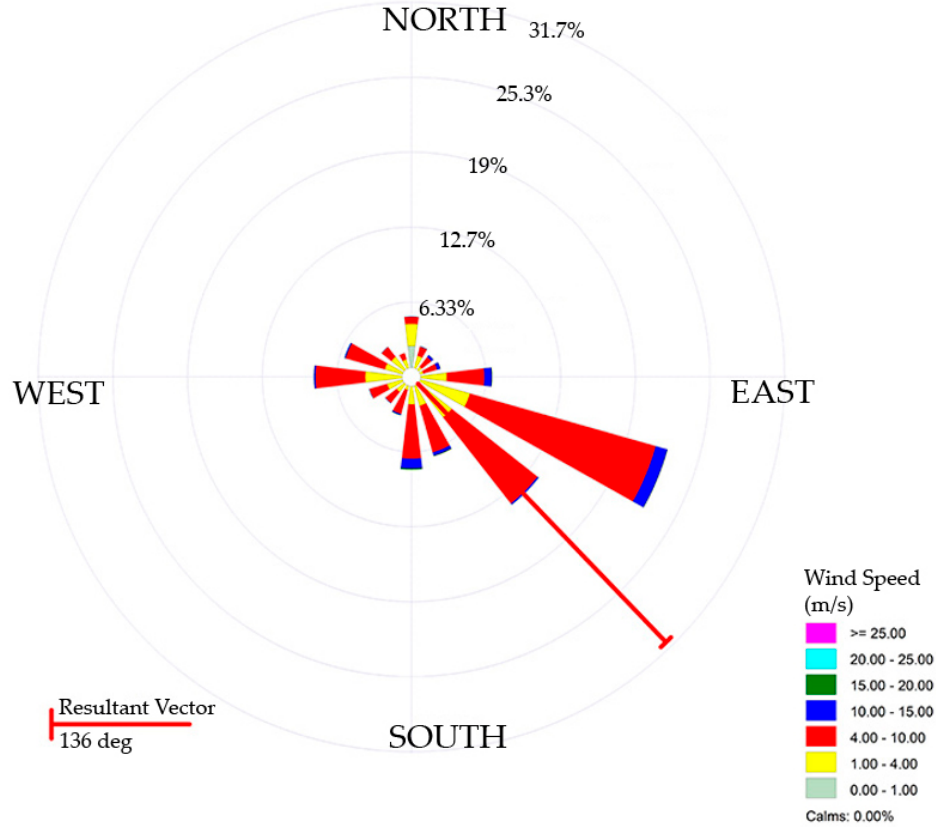
m/s. According to the windrose diagram (Figure 9), 35% of the wind in this area blows from the southeast. The resultant vector is also towards the southeast.